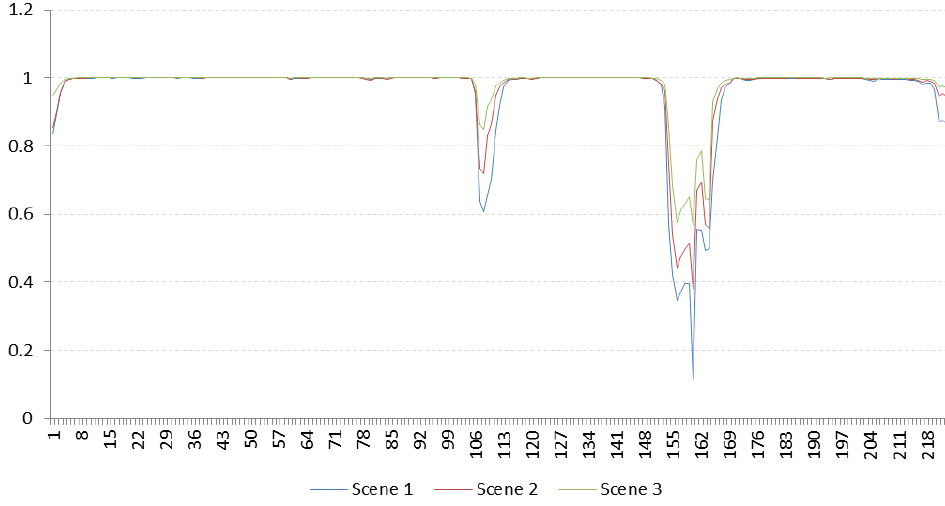
Figure 12. Correlation for continuous band for each scene of Lunar Lake.